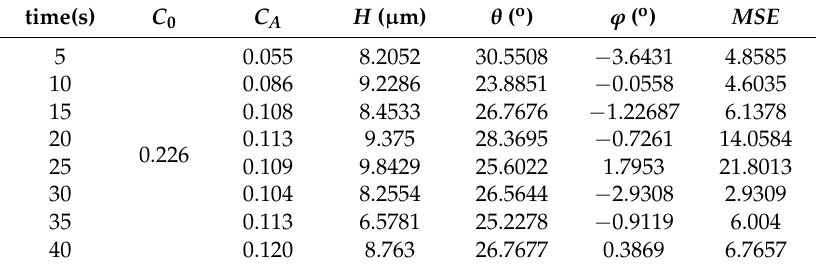
Table 4. Measured results of volume gratings with different exposure time.